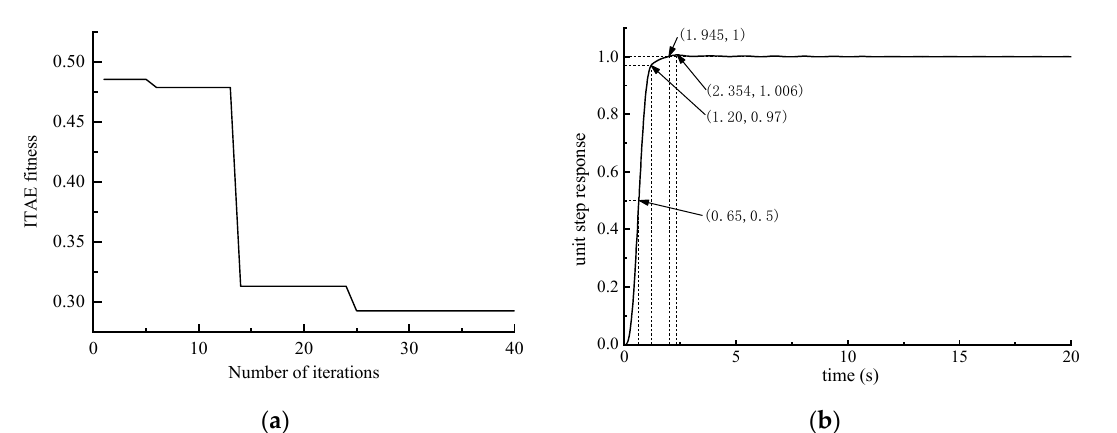
10 of 15 Figure 6. Simulation waveform of fuzzy PID control. According to Figure 6, the response time of fuzzy PID control is 4.7 s when the system error is stable within 3%, which is 2.2 s longer than that of traditional PID control. The overshoot of fuzzy PID control is 0.04, which is 0.26 more than that of traditional PID control. Therefore, it can be seen that the fuzzy PID control can adjust the PID parameters adaptively, but its system response performance is worse than that of the traditional PID